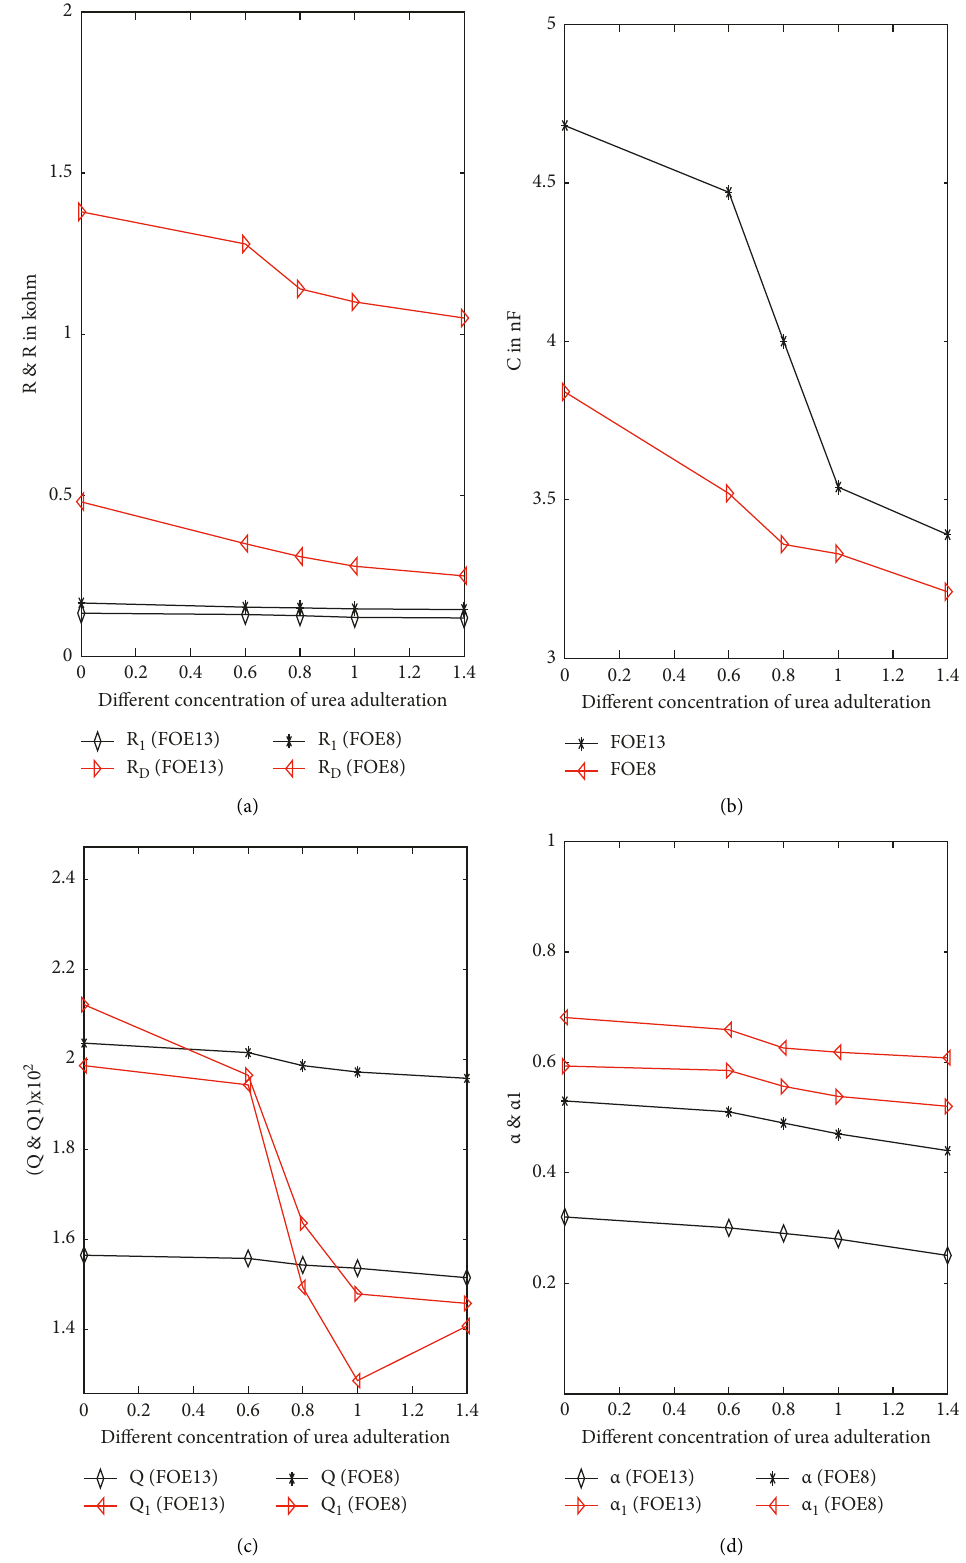
Figure 4: Variation of (a) R 1 and R D , (b) C P , (c) Q and Q 1 , (d) α and α 1 for FOE13 and FOE8 sensors with urea adulterated milk. (a) Parameter variation of R 1 and R D ; (b) Parameter variation of C P ; (c) Parameter variation of α and α 1